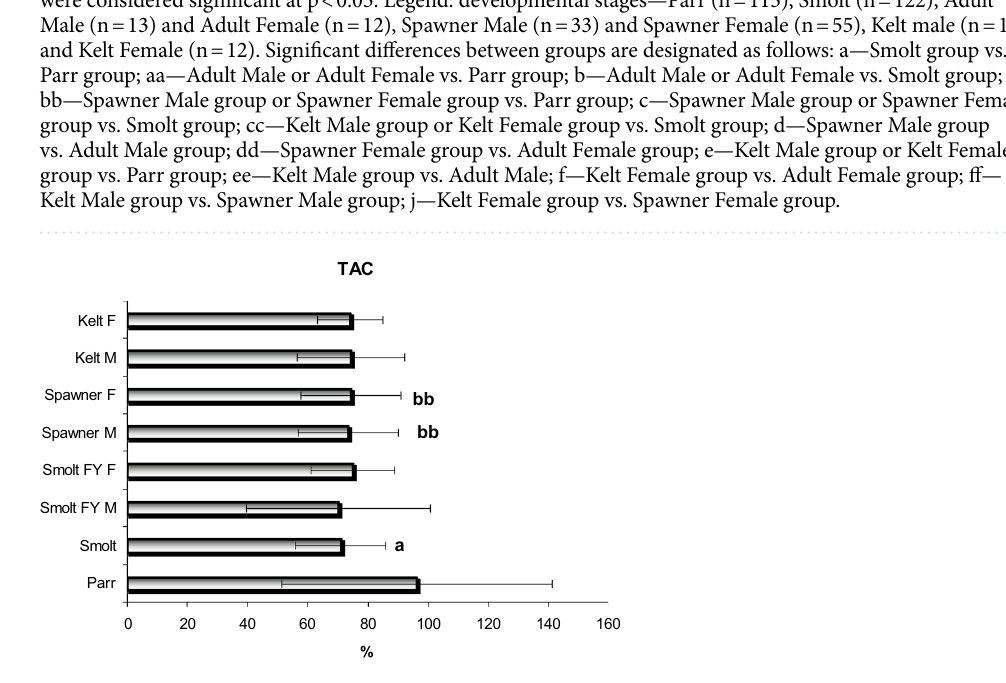
Figure 3. Total antioxidant capacity (%) in the muscle tissue of the sea trout ( Salmo trutta m. trutta L.) during different developmental stages. Results are expressed as mean ± S.D. Differences between experimental groups were analysed by one-way ANOVA and Tukey’s post-hock test for unequal observations. Differences were considered significant at p < 0.05. For Legend—see Fig.